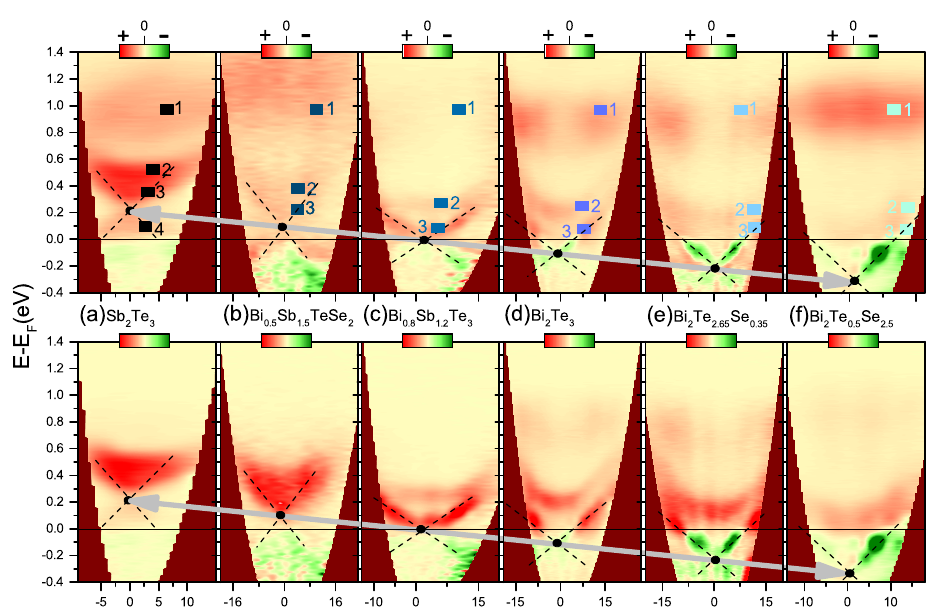
Figure 3. Photo-induced electronic population (red) and depletion (green) of the BSTS samples at 0 delay (top row) and 1 ps past the pump (bottom row). Same sample order of Figure 2 from ( a ) to ( f ). The black dashed lines highlight the TSS. The thick gray arrows connect the Dirac nodes (DN) of the BSTS compounds. The small boxes labeled 1 to 4 show the integration windows used to estimate the temporal dynamics on the different bands. The box color becomes lighter as the sample passes from p-doped (panel a ) to n-doped (panel f